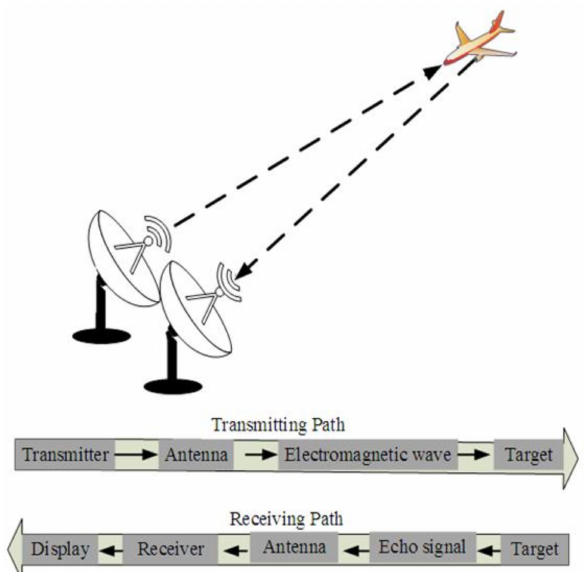
Figure 2. A general principle of the simple monostatic continuous radar